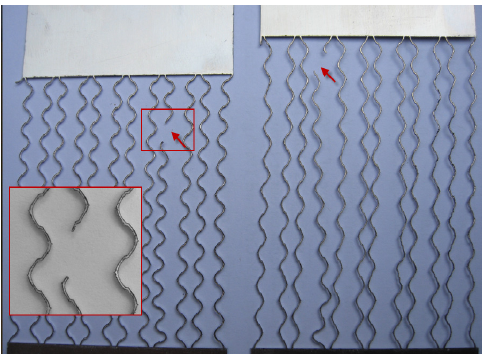
Figure 4: Comparison of the two 2D samples after fracture test: the original design (left) ruptured at lower elongation than the optimized one